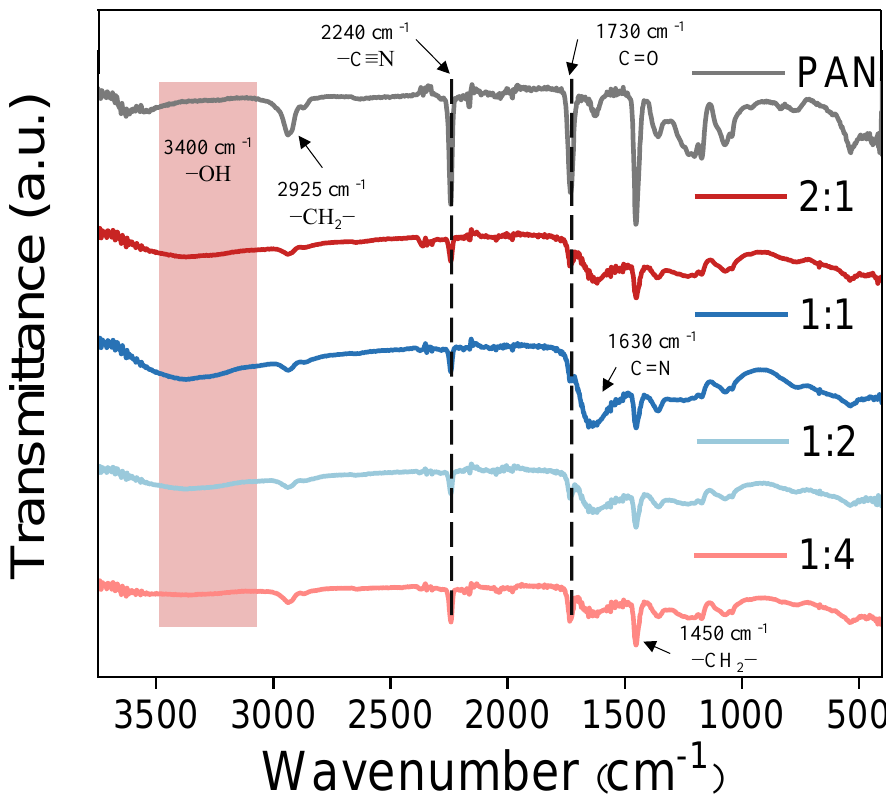
Figure 5. FT−IR spectrum of PAN UF membrane and PG/TEPA NF membranes with different PG and TEPA mass ratios. (The effect of different ratios on the chemical properties of the membrane is investigated under the condition that the reaction time is 2 h and the pH is 8.5).